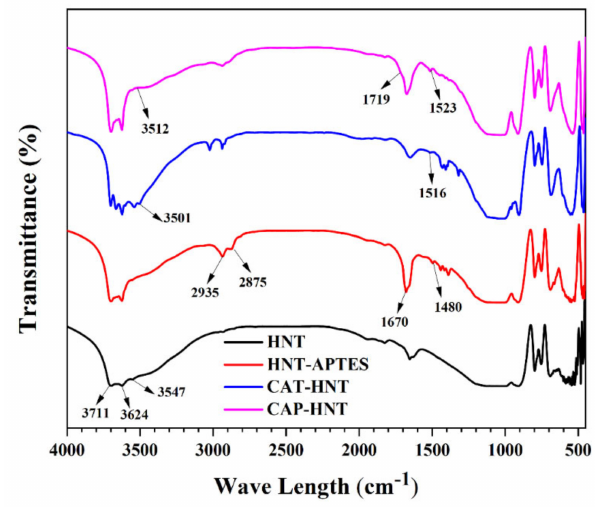
Figure 3. FTIR spectra of the pristine HNTs and of the HNTs surface modified with APTES, CAT, and